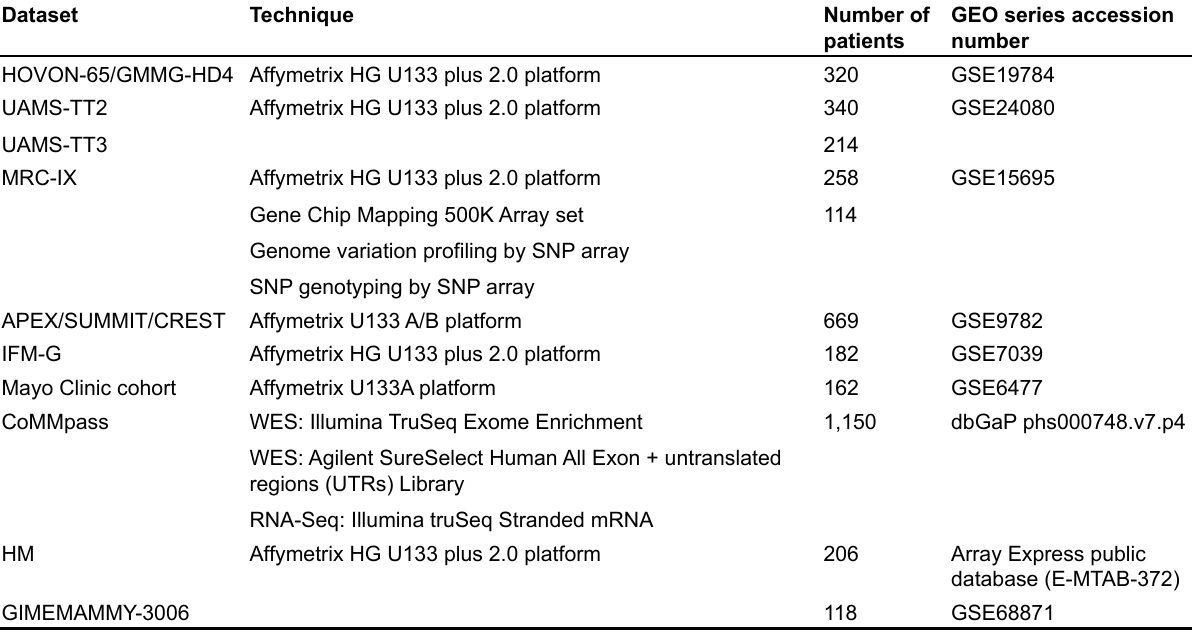
Table 2. Datasets from MM patients used in genomics studies presented in this review